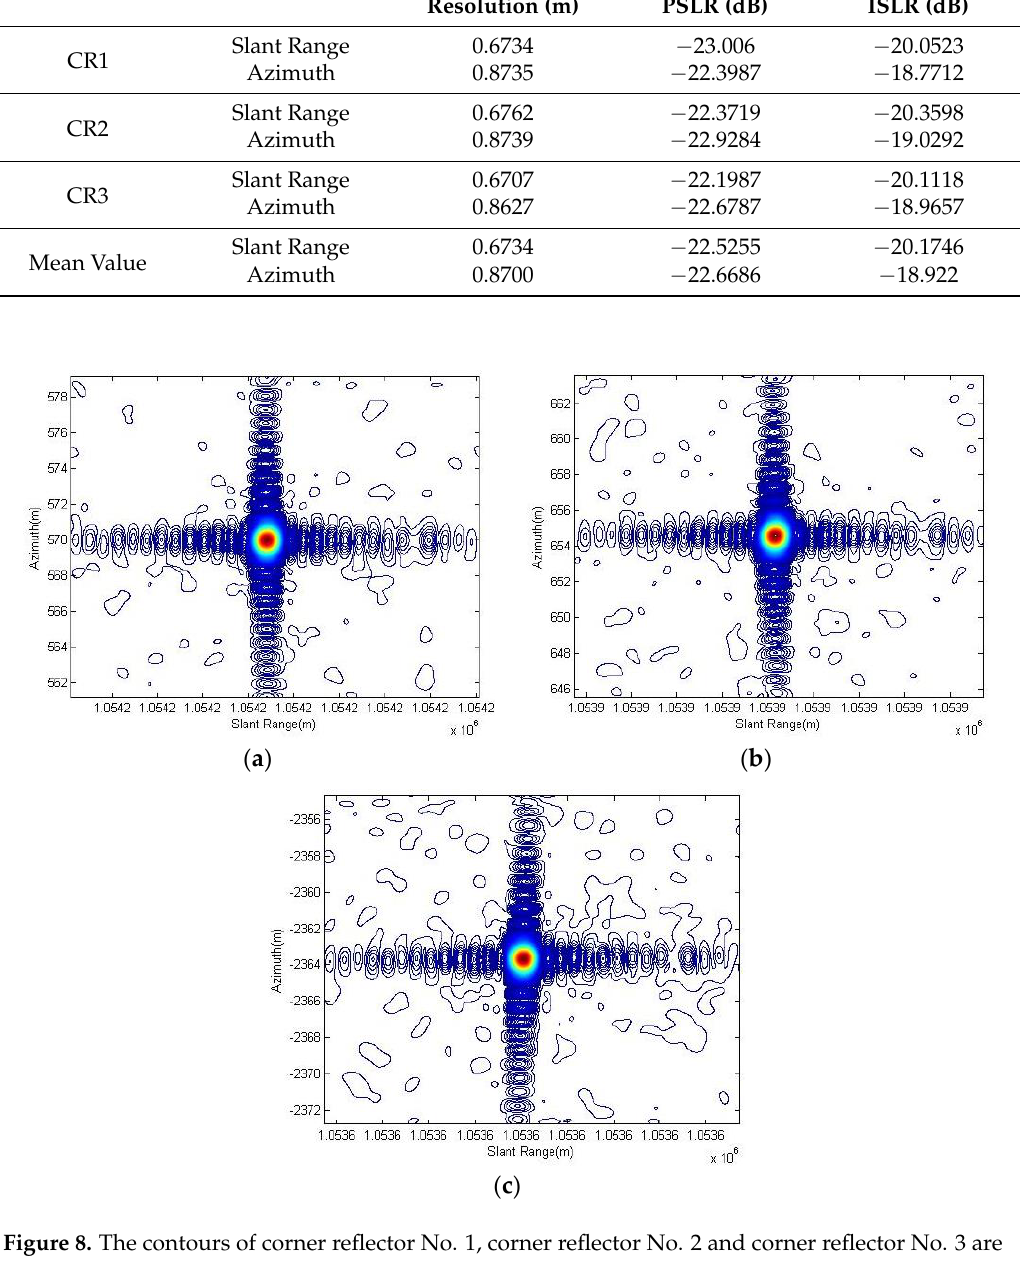
Figure 8. The contours of corner reflector No. 1, corner reflector No. 2 and corner reflector No. 3 are shown in ( a – c ) respectively. These were given after the spotlight processor applied the enhancements.